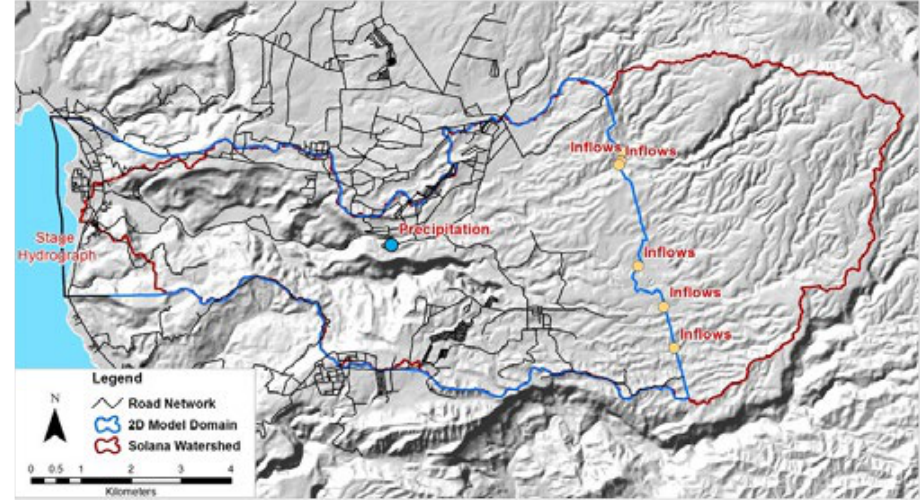
Fig. 2: Boundary conditions in the 2D model domain in Solana watershed.